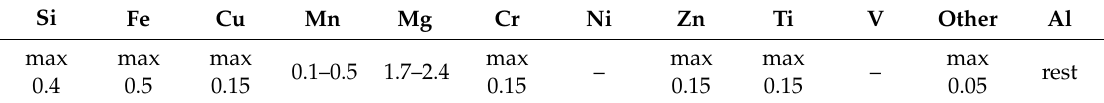
Table 1. Chemical composition of the EN AW-5251